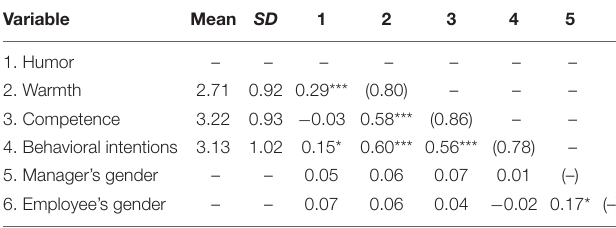
TABLE 2 | Descriptive statistics and intercorrelations – Study